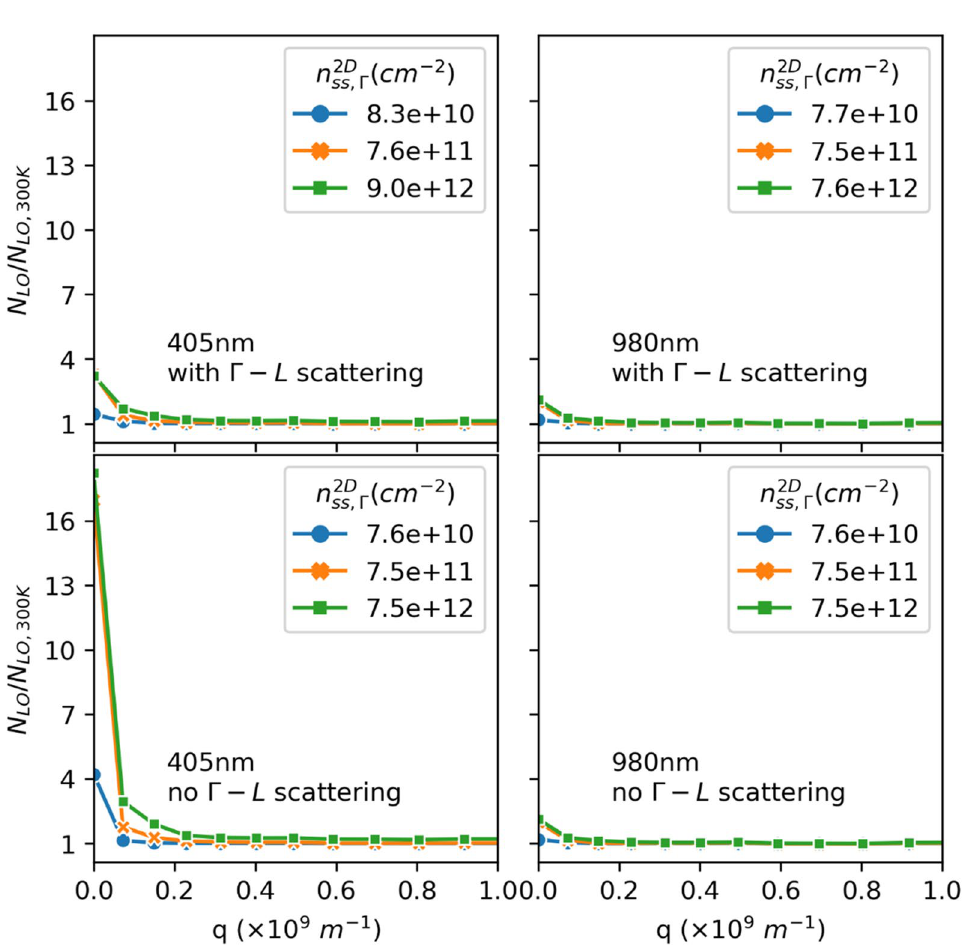
Figure 7. EMC LO phonon occupation as a function of wavevector q. Results are shown for different excitation wavelengths and carrier densities, with and without intervalley Ŵ –L